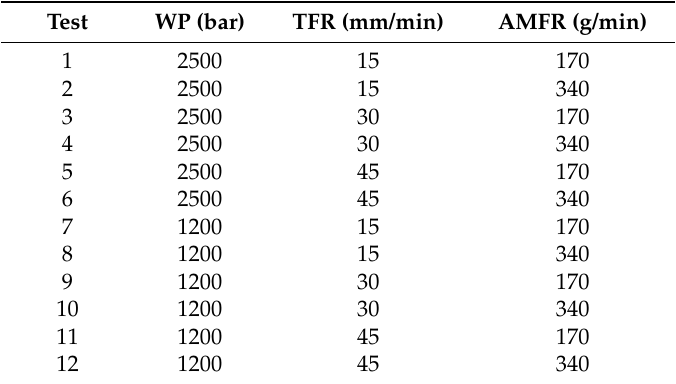
Table 3. Parameters used for each